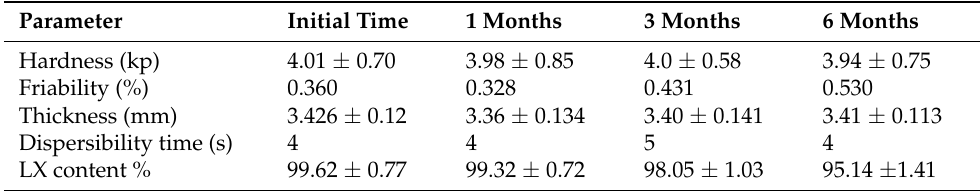
Table 6. Quality control results of LXDTs during accelerated stability study. Data are represented as Mean ± SD (n =